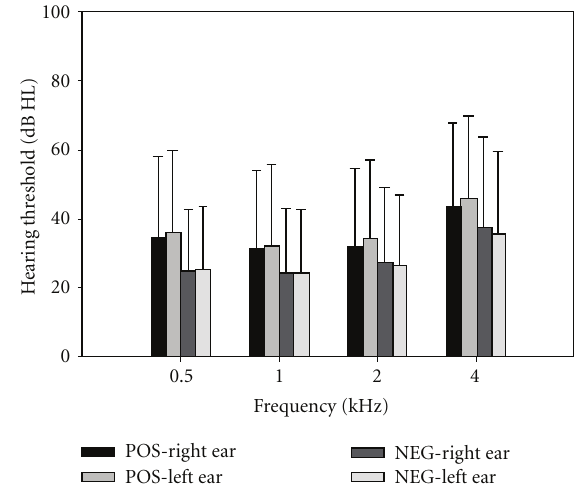
Figure 7: Means and standard deviations of the hearing thresholds as measured at 0.5, 1, 2, and 4kHz for the “positive” and “negative” ECochG